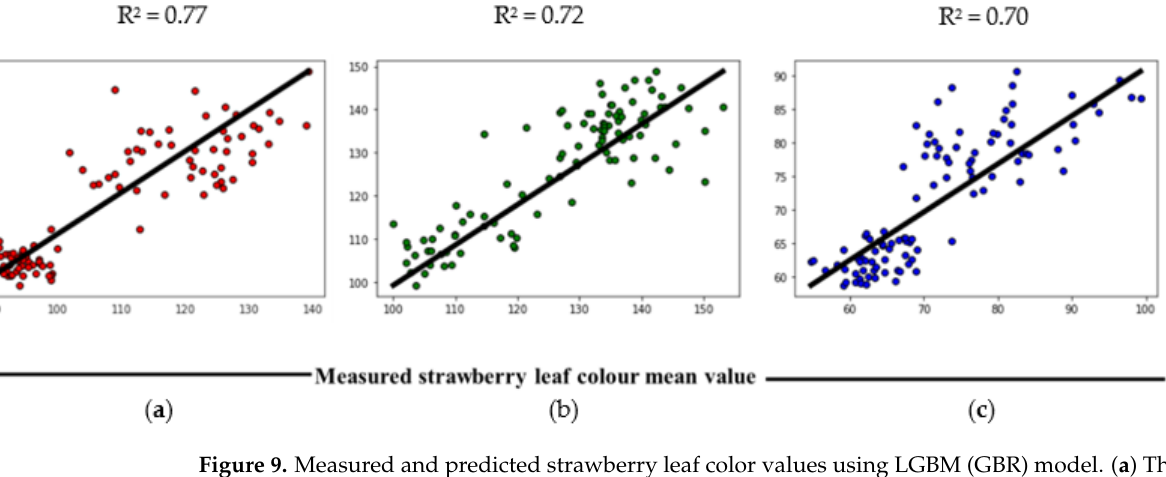
Figure 9. Measured and predicted strawberry leaf color values using LGBM (GBR) model. ( a ) The Scatter plot of measured and predicted R mean value. ( b ) The Scatter plot of measured and predicted G mean value. ( c ) The Scatter plot of measured and predicted B mean value.